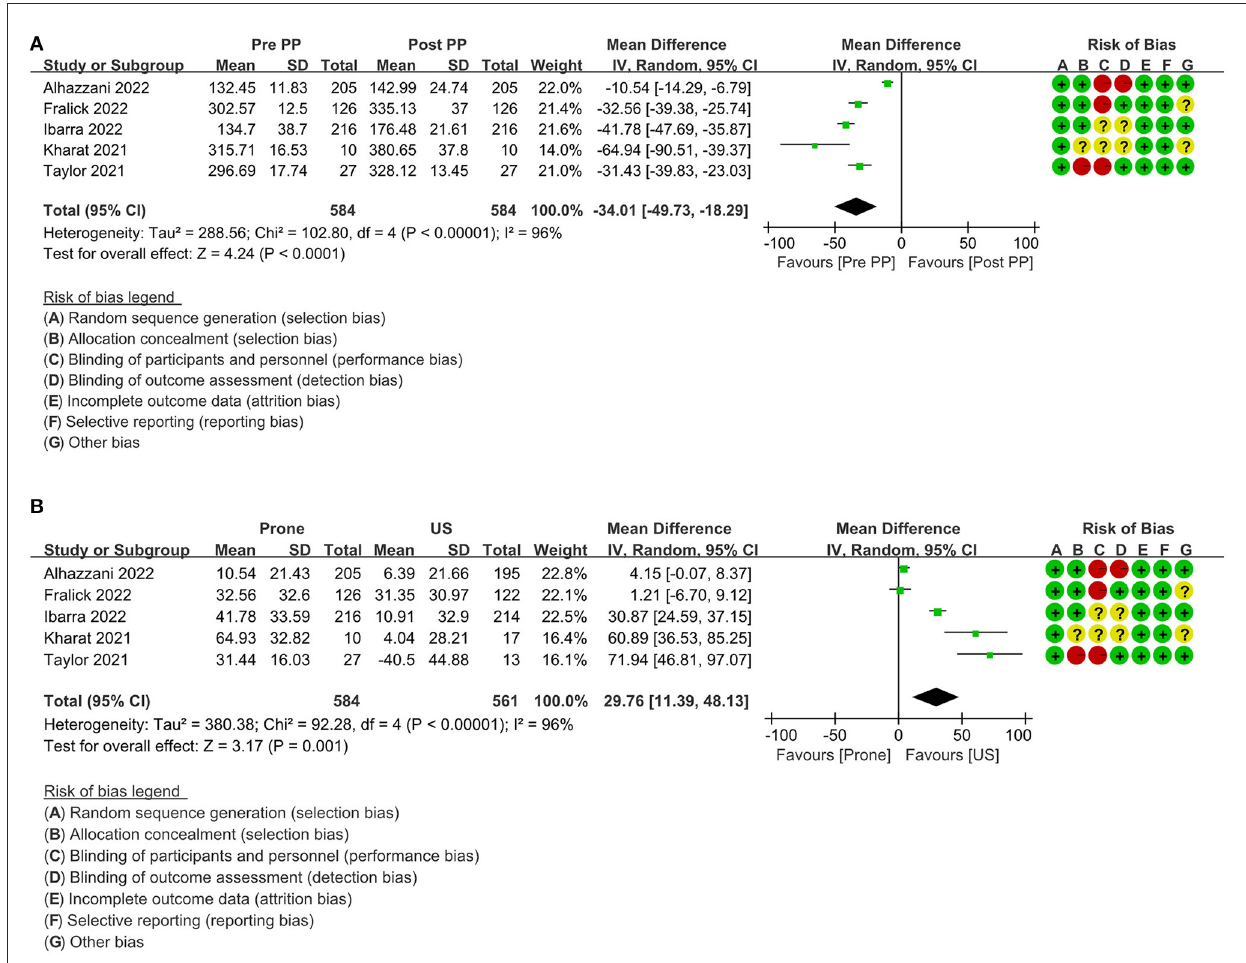
FIGURE3 Primary outcome: forest plot of SpO 2 /FiO 2 ratio in the random-effects model. (A) pre-PP vs. post PP; (B) prone vs. US; PP, prone position; US, usual care; SD, standard deviation; IV, inverse variance; CI, confidence